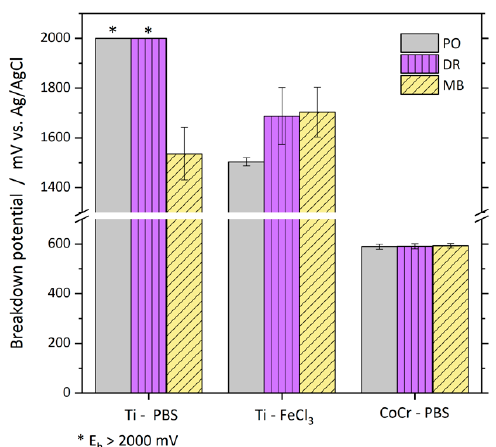
Figure 5. Breakdown potential (E b ) of polished (PO), deep-rolled (DR) and microblasted (MB) Ti6Al4V samples tested in PBS and in FeCl 3 -containing electrolyte (FeCl 3 ) and of polished, deep-rolled and microblasted CoCrMo samples tested in PBS. Values comprise all four anodic polarization scans of three tested samples. Values marked with * refer to breakdown potentials above 2000 mV.